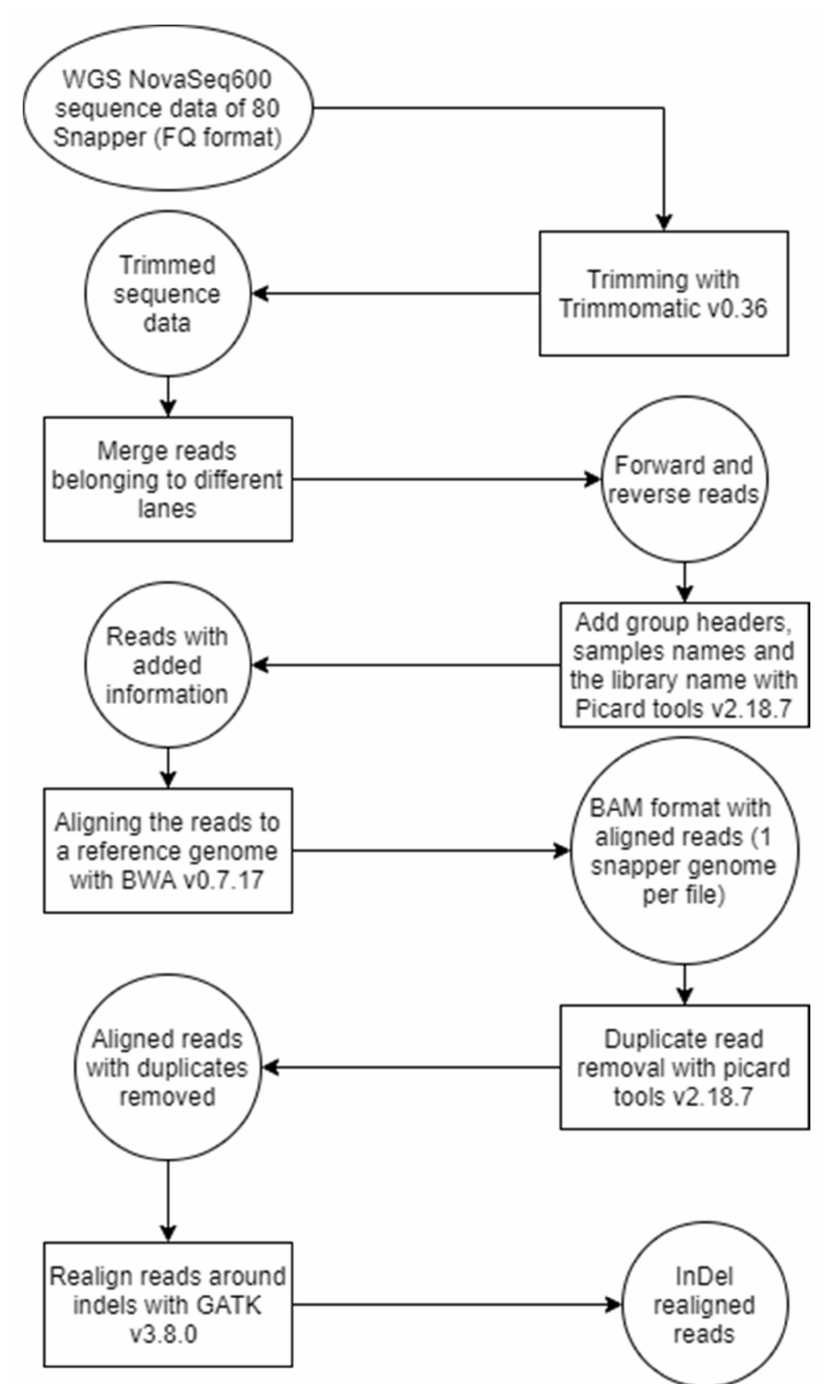
Figure 1. Overview of the processing of the genomic